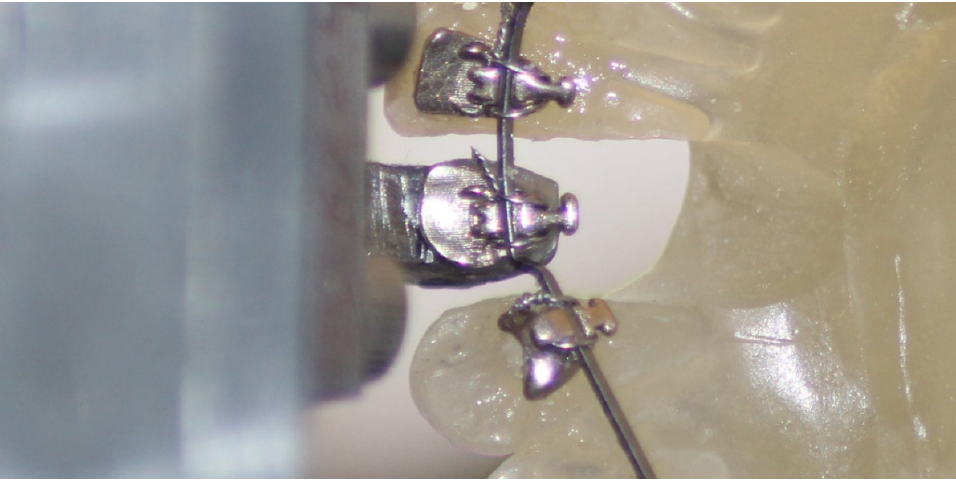
Figure 1. Resin cast bonded with the Incognito TM appliance and adjusted in the OMSS chamber.